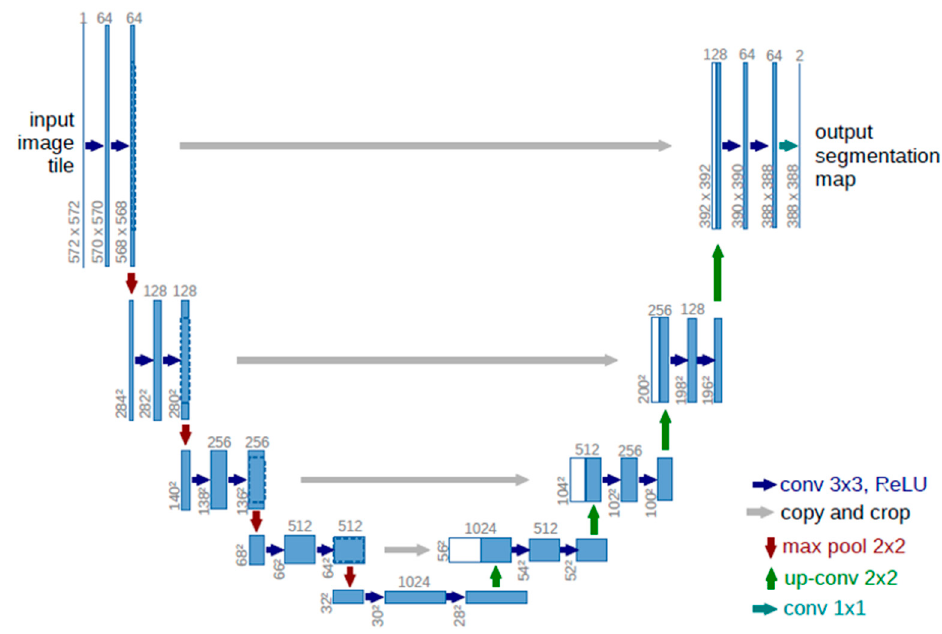
Figure 2. The U-Net